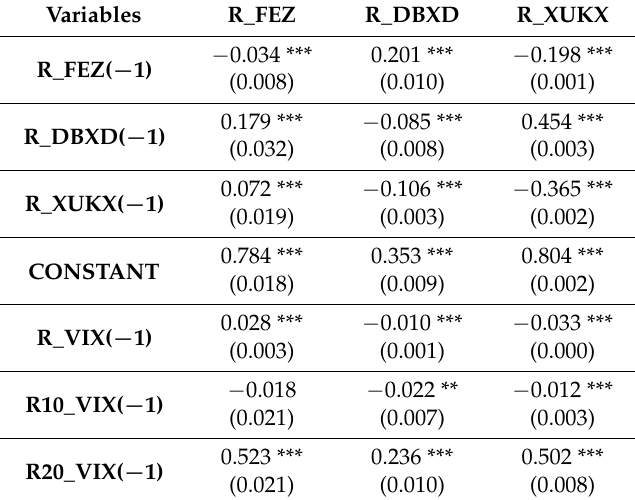
Table 10. Mean Equation for European Market ETF and VIX (Before GFC) (10 September 2007 to 30 October